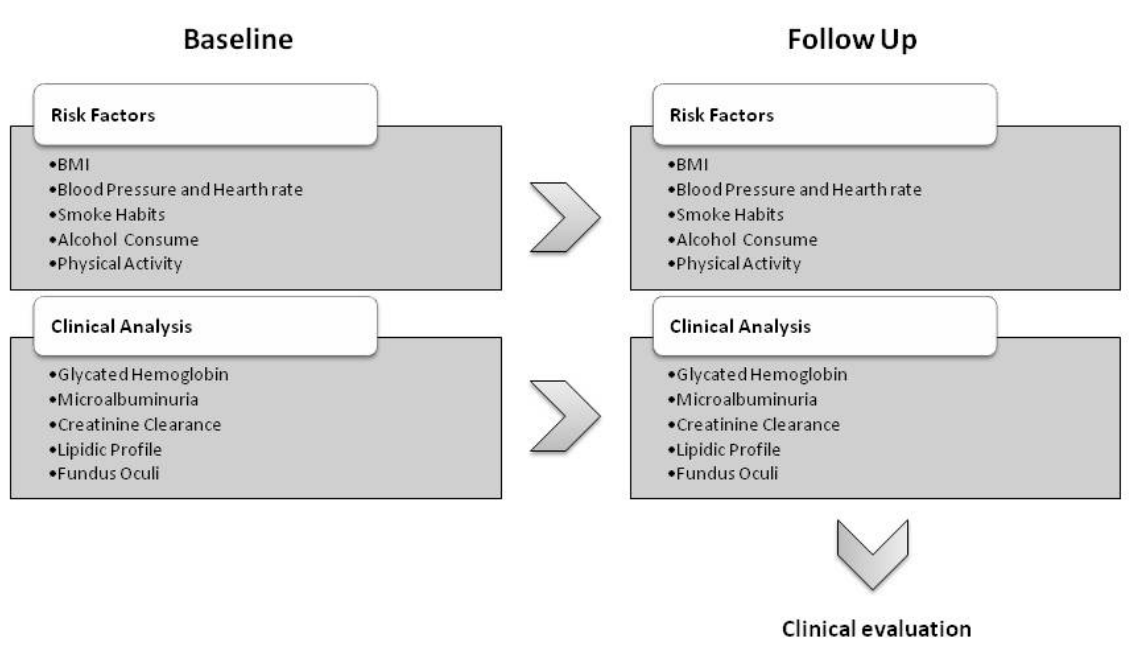
Figure 1. PDTA organization and data collected during baseline and follow-up examinations. Abbreviations: BMI, body mass index.